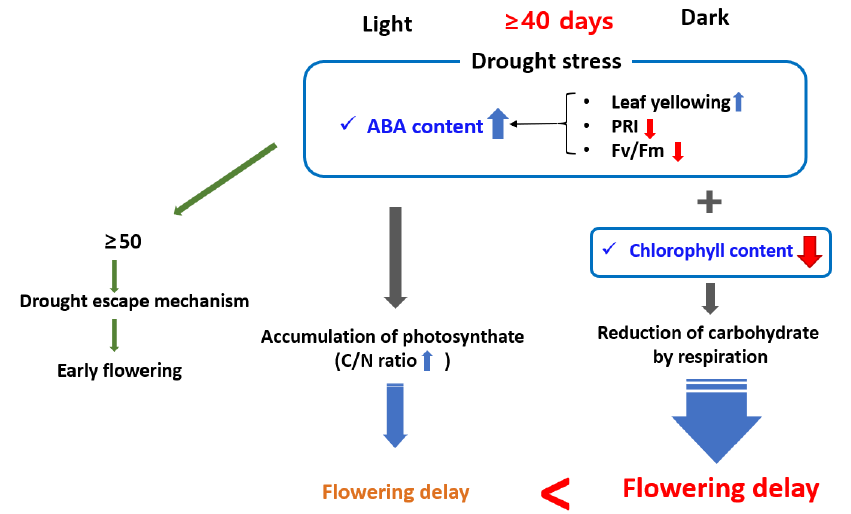
Figure 12. Simplified schemes representing the flowering in Phalaenopsis Sogo Yukidian ‘V3’ under drought stress in light and dark conditions.